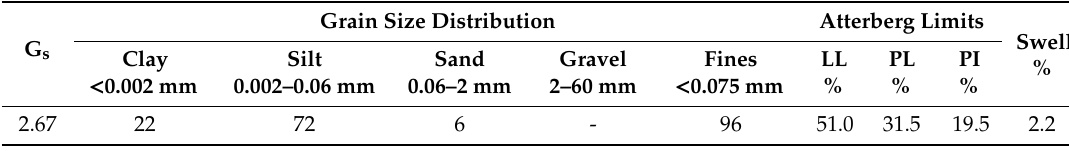
Table 1. Physical properties of the high plasticity (CH) clay.